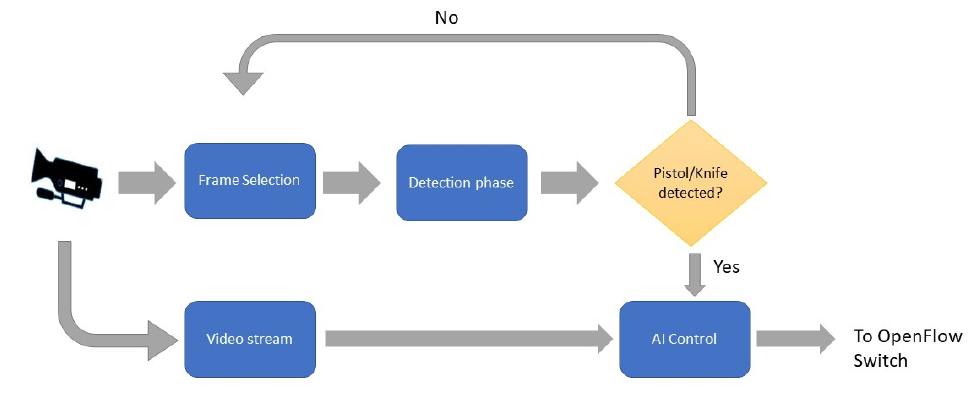
Figure 2. Proposed deep learning based weapon detection